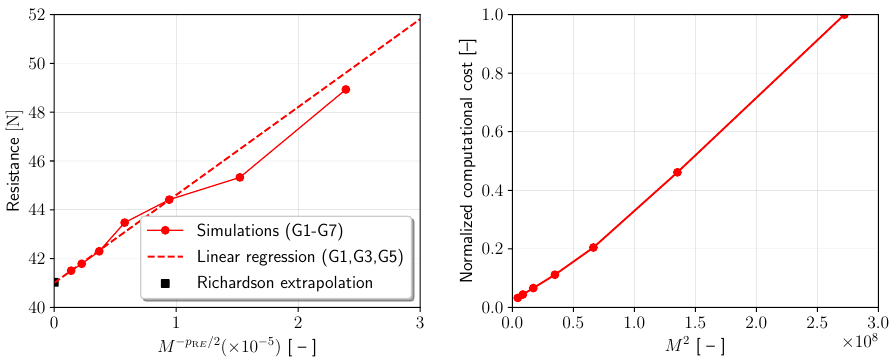
Figure 1. Hull ( left ) and free-surface ( right ) discretizations for the highest (G1, top) and lowest (G7, bottom) fidelities.